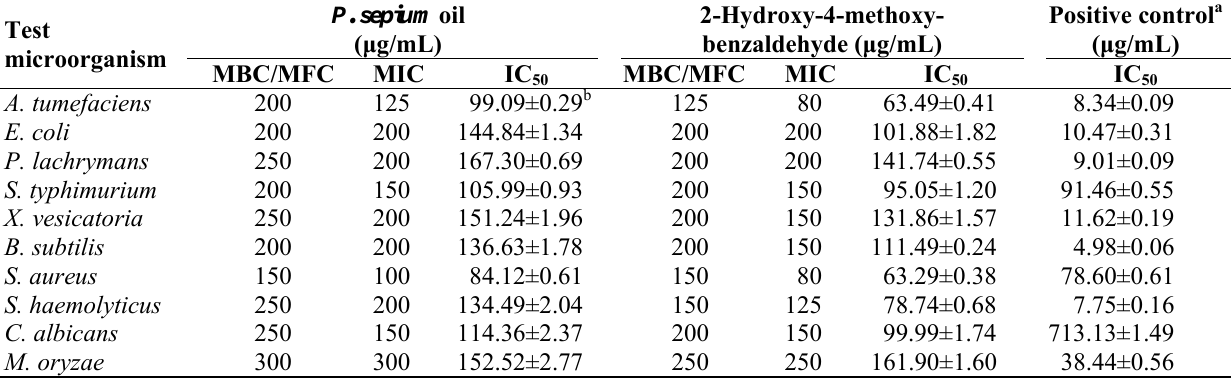
Table 2. Antimicrobial activity of P. sepium essential oil and 2-hydroxy-4-methoxy